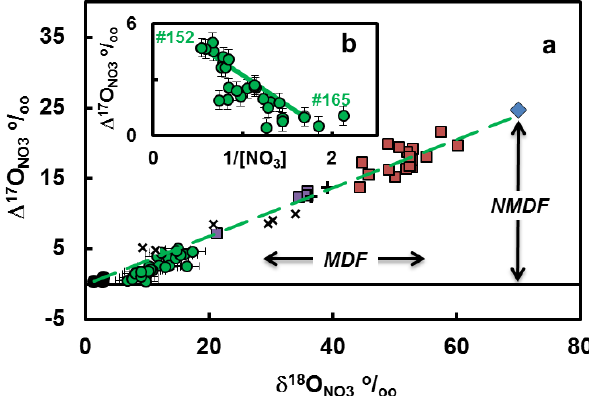
Fig. 6. The isotope composition as a function of the concentration of dissolved